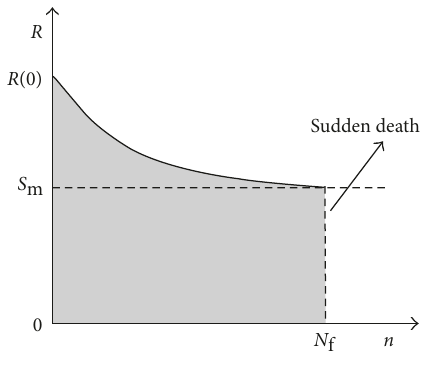
Figure 10: The residual strength